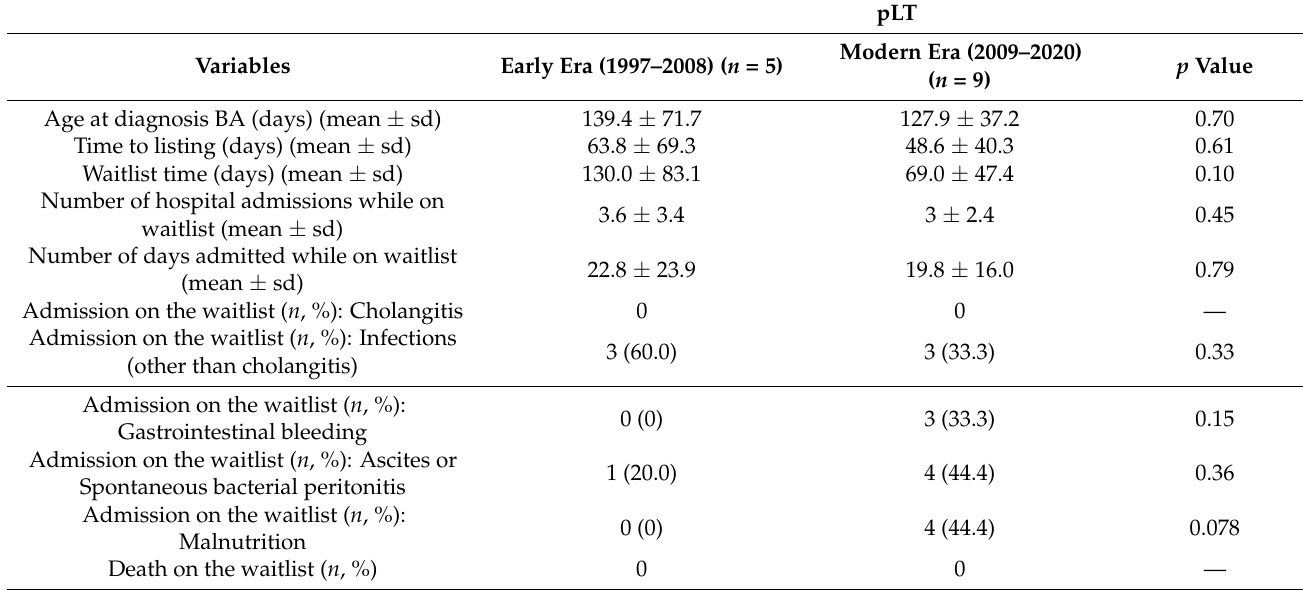
Table 7. Pre-transplant comparison of patients transplanted after pLT based on era: demographics, diagnosis of BA and waitlist-related data.